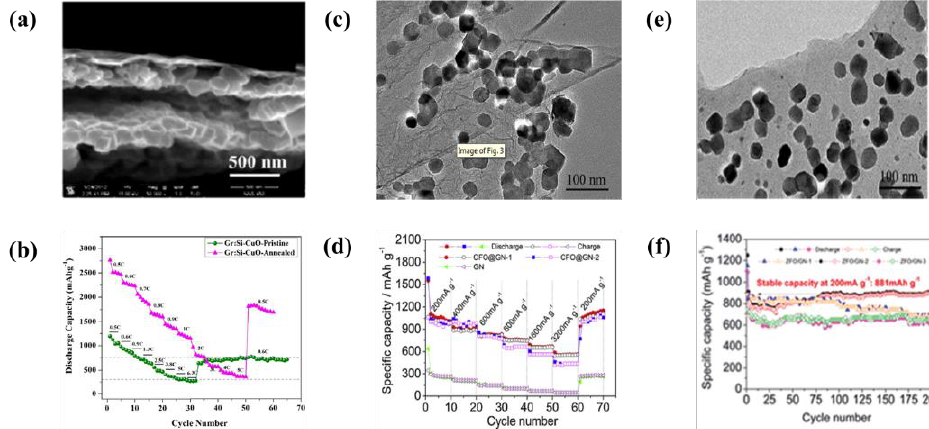
Figure 14. ( a ) SEM image of a graphene/Si-CuO QD multi-layered film electrode; ( b ) Cycling performance of a graphene/Si-CuO QD multi-layered film electrode; ( c ) SEM image of graphene/ZnFe 2 O 4 nanoparticle electrode; ( d ) Cycling performance of a graphene/ZnFe 2 O 4 nanoparticle electrode; ( e ) SEM image of a graphene/CoFe 2 O 4 nanoparticle electrode; ( f ) Cycling performance of a graphene/CoFe 2 O 4 nanoparticles electrode.